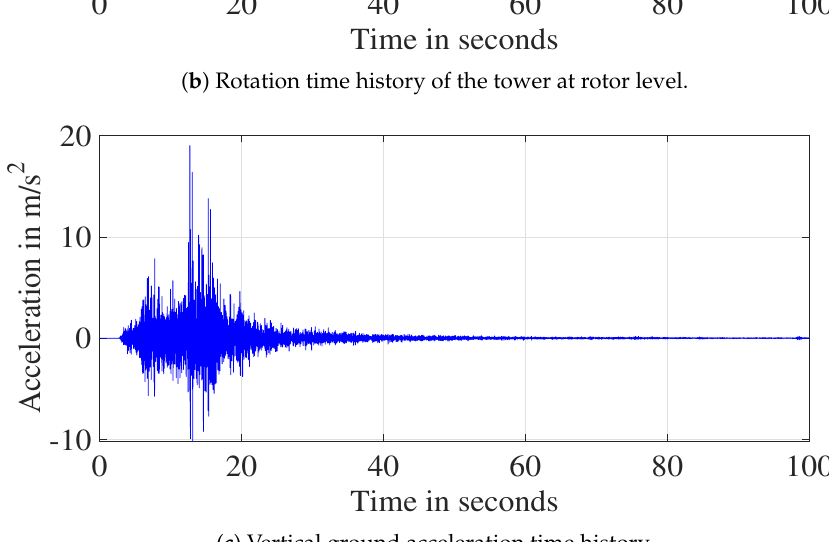
( c ) Vertical ground acceleration time history. Figure 18. Seismic response of TLP floating wind turbine under vertical ground acceleration. From Figures 17 and 18, it is clear that the seismic response of TLP-type floating wind turbines are more sensitive to vertical ground motion than the horizontal ground motion. The overturning failure of the floating wind turbine under vertical ground motion is shown in Figure